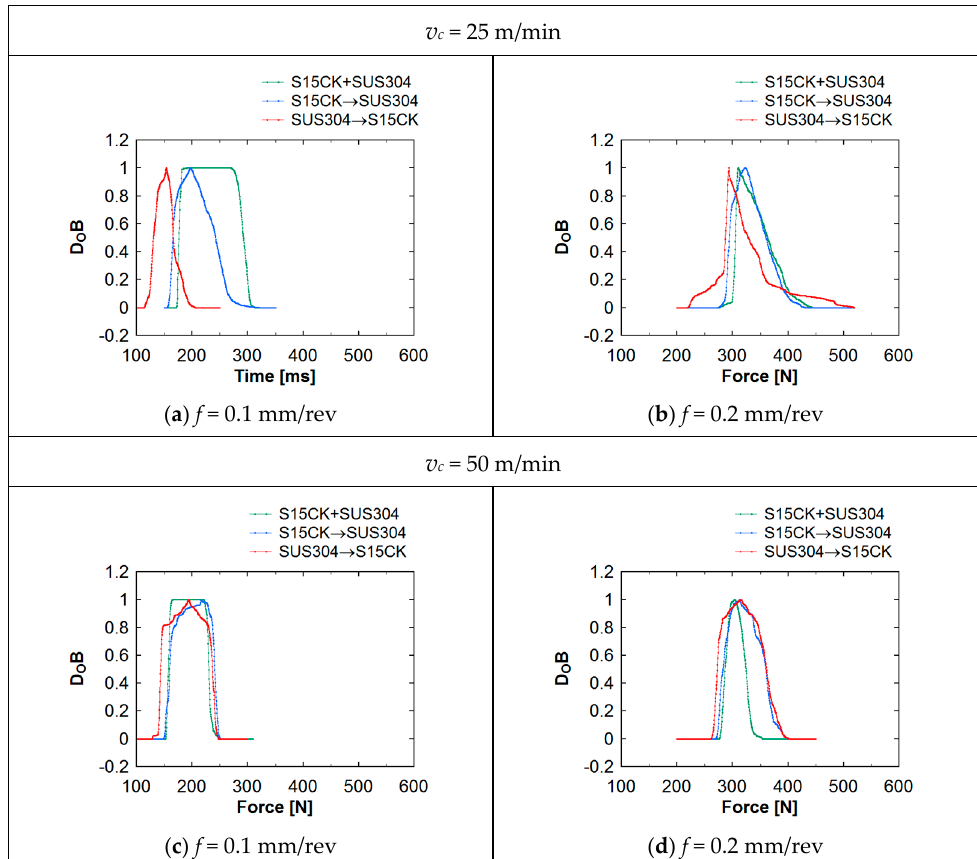
Figure 5. Uncertainties in the machining forces underlying SU − SC.